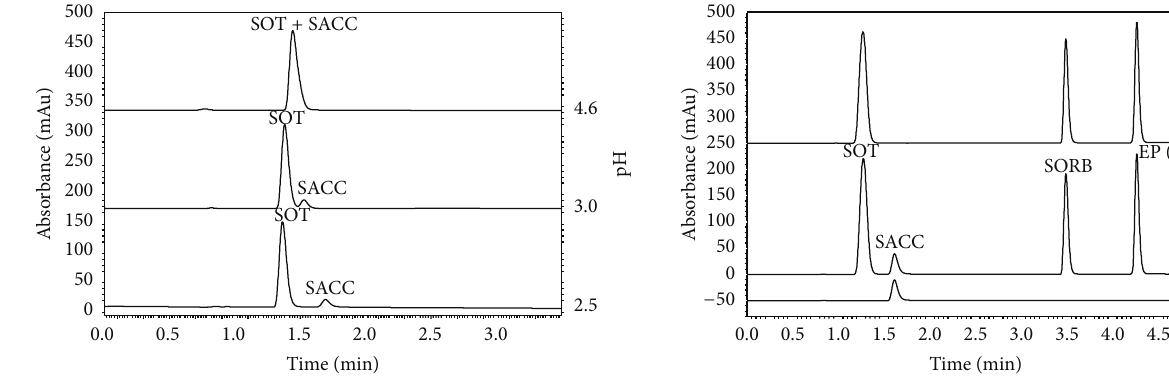
Figure 1: Significance of mobile phase buffer pH controlling in SOT/SACC separation; pharmaceutical formulation F4 (1.000 mL of pharmaceutical preparation diluted to 25.00 mL); injection volume 5 𝜇 L; mobile phase flow 1.3 mLmin −1 ; linear gradient (ACN: 10% to 60% in 4 minutes); UV/Vis detector wavelength 237 nm; column oven 25 ∘ C.